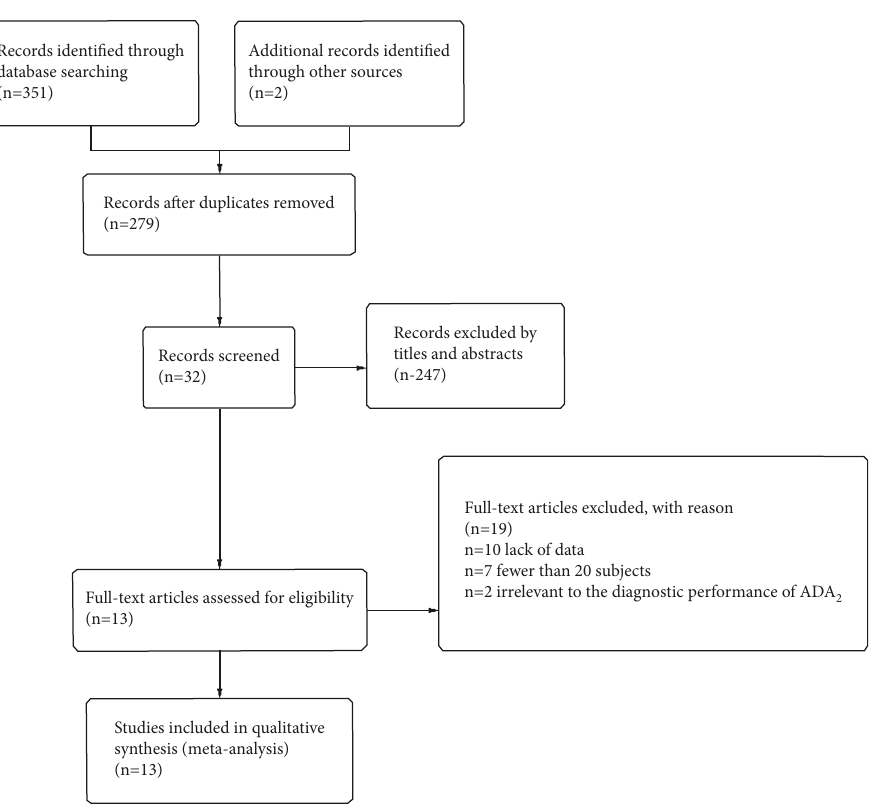
Figure 1: PRISMA flowchart of the selection